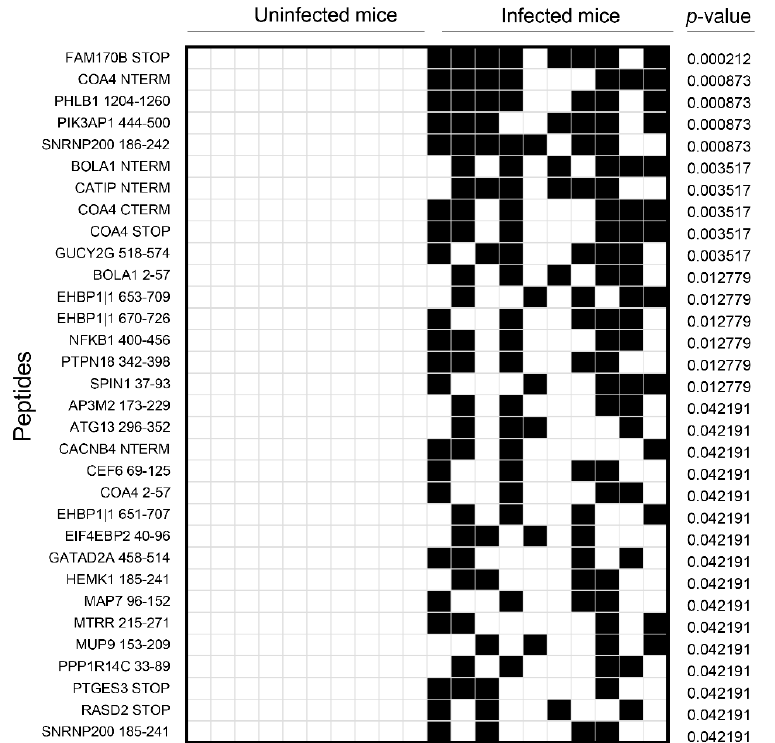
Figure 2. Mouse proteins identified by PhIP-Seq. Sera collected from CVB3-infected or control animals were subjected to PhIP-Seq using the mouse peptide library as described in the methods section. Differential abundance of antibody reactivities to mouse peptides was determined in the corresponding groups using the EdgeR software, and the data were compared between groups using Barnard’s exact test. Each column represents one animal. Blank and filled squares represent absence and presence of antibody reactivities, respectively ( n = 10 animals per